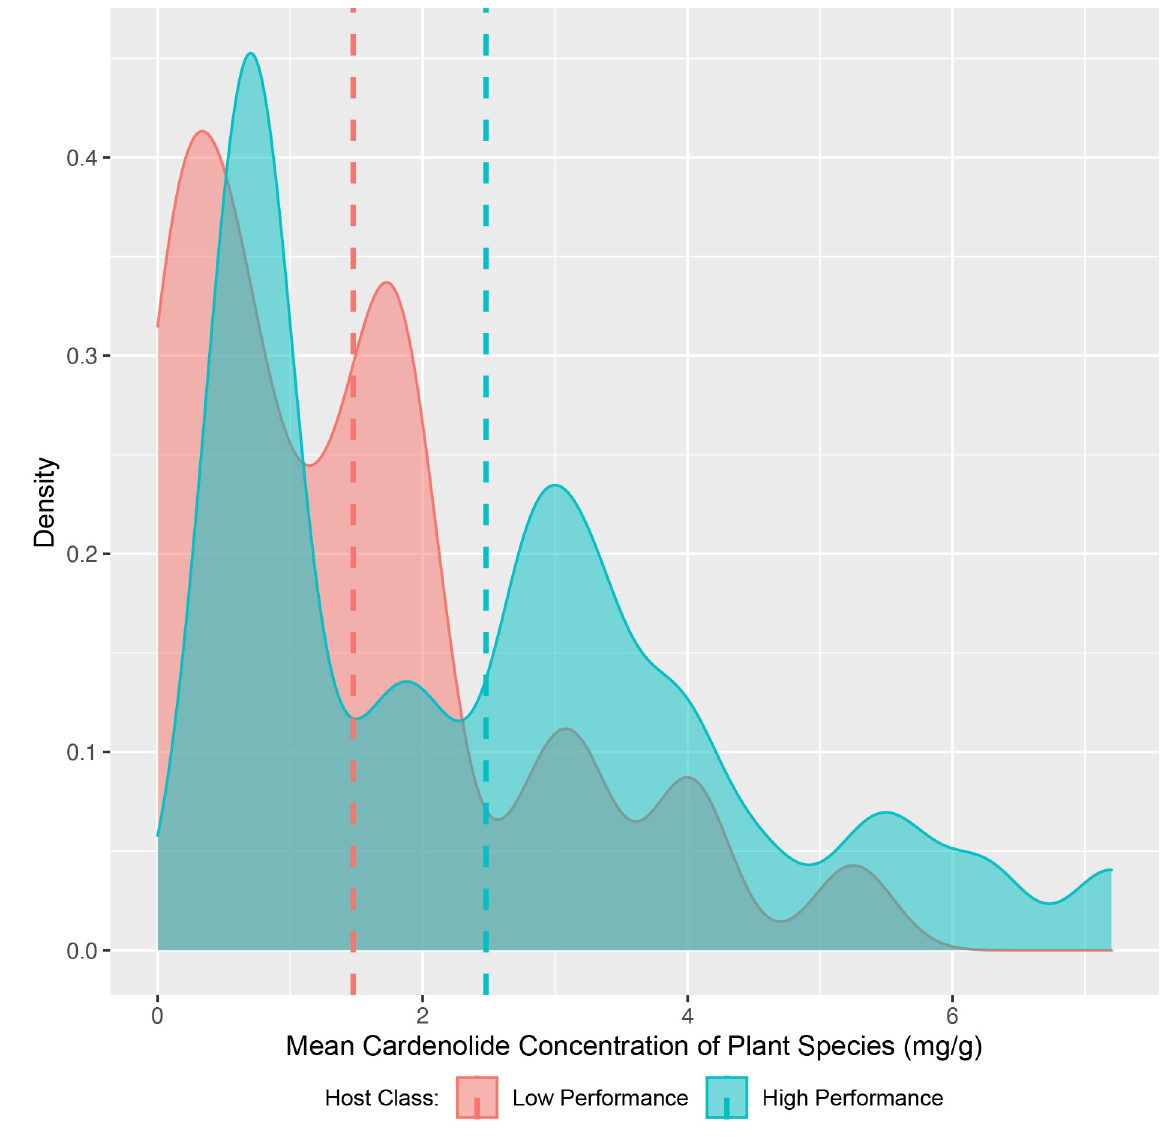
Fig 2. Density plot of plant species mean cardenolide concentrations. Vertical, dashed lines indicate mean